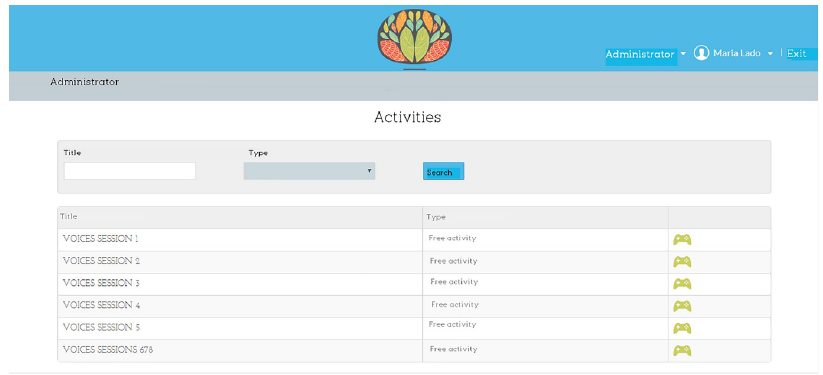
Fig 3. Voices program. Reprinted from www.e-motionaltraining.com under a CC BY license, with permission from Fundacio´n Biome´dica Galicia Sur, original copyright 2018.